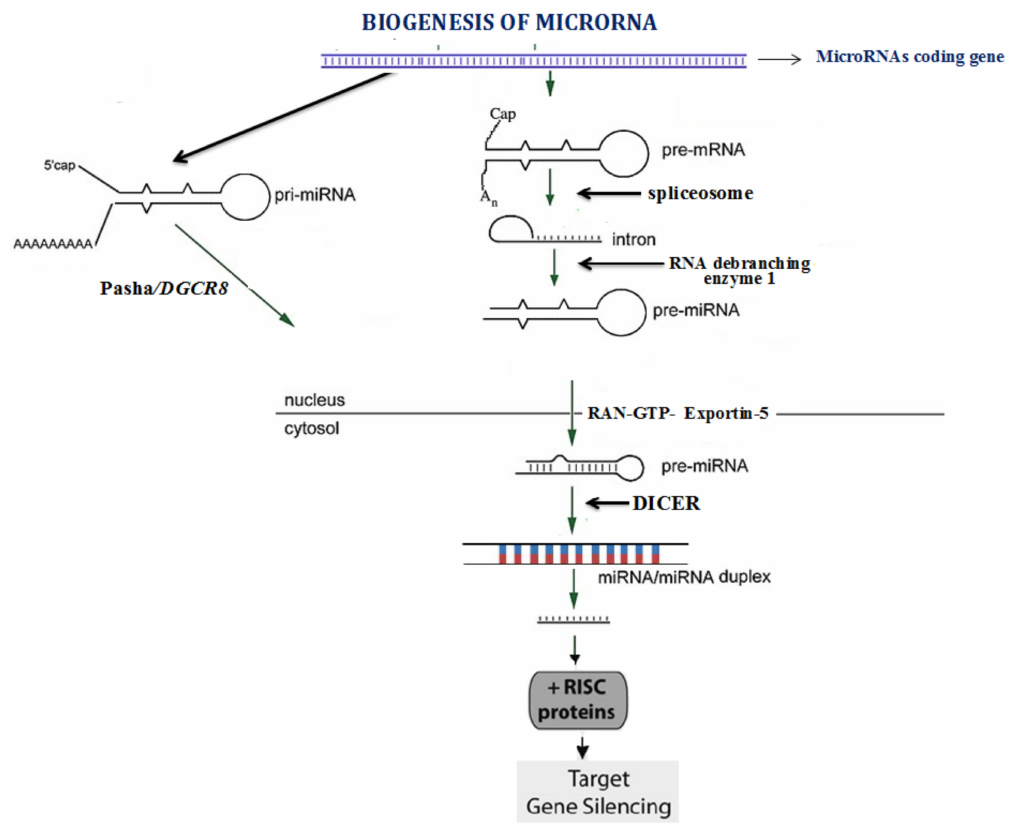
Figure 1. Biogenesis of